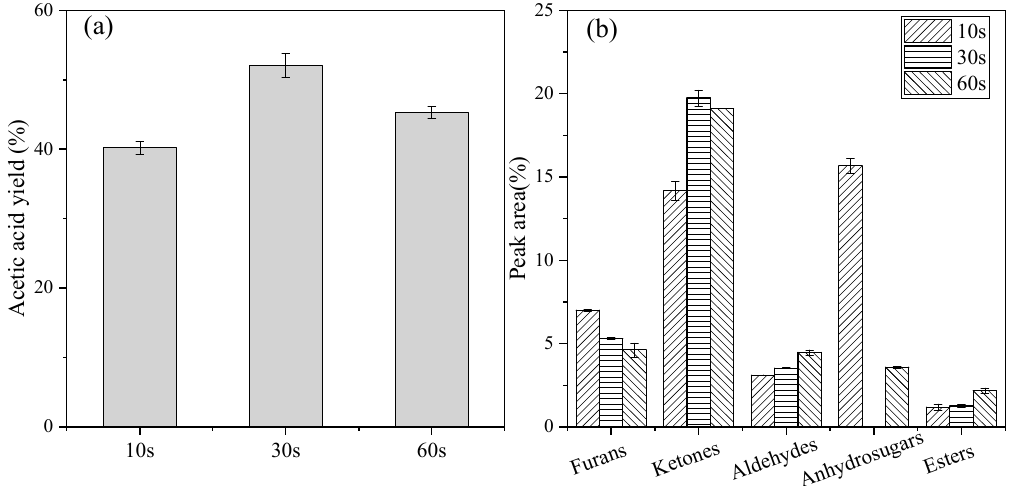
Figure 3. Comparison of the AA yields ( a ) and the product distributions ( b ) of the glucose in situ catalytic pyrolysis with a glucose/KAc ratio of 1:0.25 at 350 °C for 10 s, 30 s and 60 s. Figure 3a reflects the e ff ect of the di ff erent heating times on the yield of AA, the